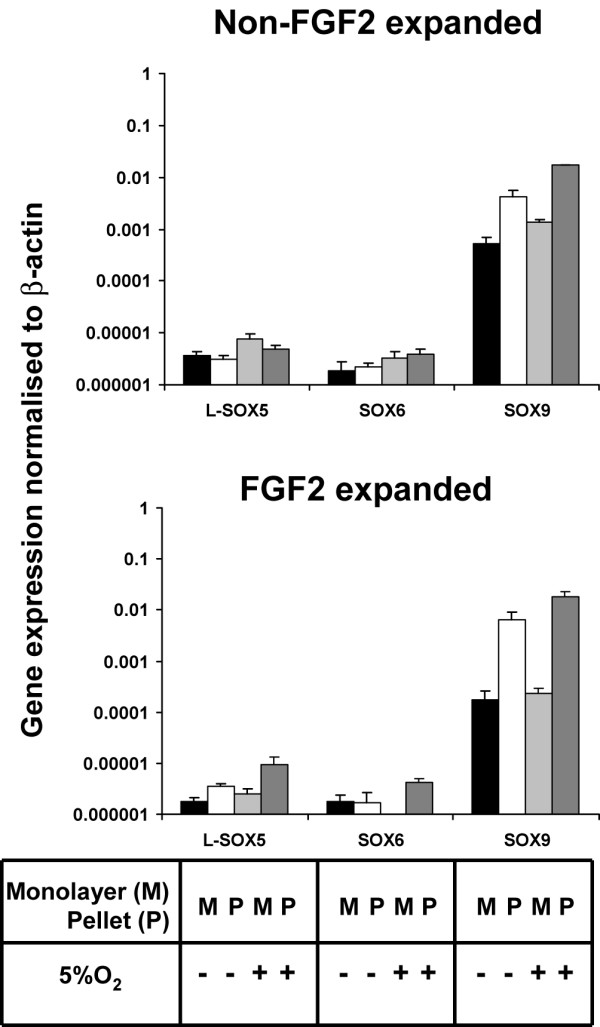
Sox gene expression in monolayer and cell aggregate cultures. Gene expression for monolayer cells (black bars) between P2 and P3 in standard medium (n = 3), for cell aggregate (white open bars) culture in chondrogenic differentiation medium after 14 days of culture under normoxia (n = 3). Gene expression for monolayer cells (light grey bars) between P2 and P3 in standard medium (n = 3) and for cell aggregate (dark grey bars) in chondrogenic differentiation medium after 14 days of culture under low oxygen tension (n = 3). *p < 0.05; **p < 0.001 (Student's unpaired t test) in cell aggregates from fibroblast growth factor 2 (FGF2)-expanded versus non-FGF2-expanded cells. P2, passage 2; P3, passage 3.